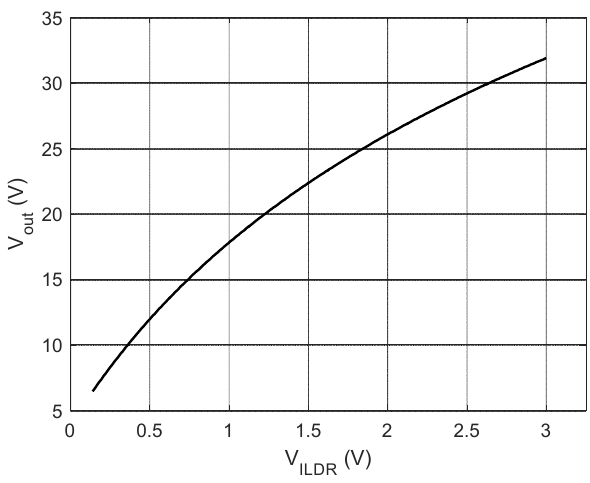
Figure 10. The relationship between the output voltage and the command from the control unit.